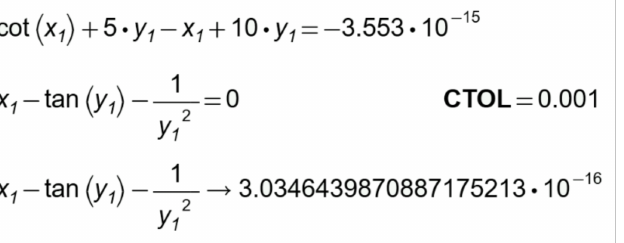
Figure 4. Mathcad instructions for a precision check for the numerical solution of